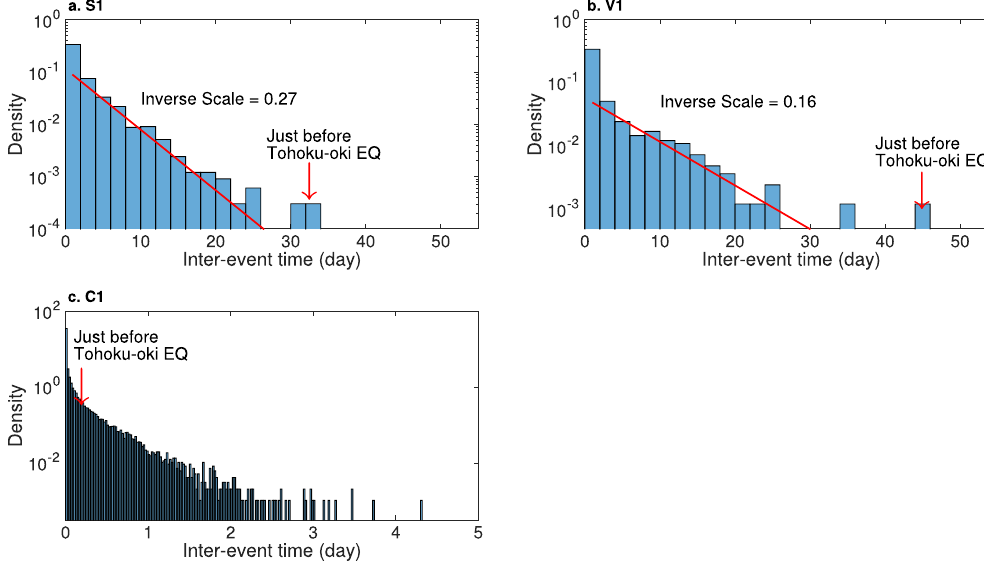
Figure 6. Distributions of inter-event time (density). Panel a for class S1. In this panel, we discarded inter-event times smaller than the cutoff interval for class S1. The red line was estimated by fitting a truncated exponential distribution with lower cutoff of 1 day where the mean was evaluated by a robust statistics with median/log(2), which is less influenced by outliers 55 . The estimated density function was normalized such that the sum of probability that inter-event time is greater than one day matches the empirical one. The slope of the line (inverse scale for exponential distribution) is displayed as text. Panel b: the same plot for class V1 of volcanic tremors. Panel c: the same plot for class C1 of conventional EQs. In this panel, we did not fit an exponential